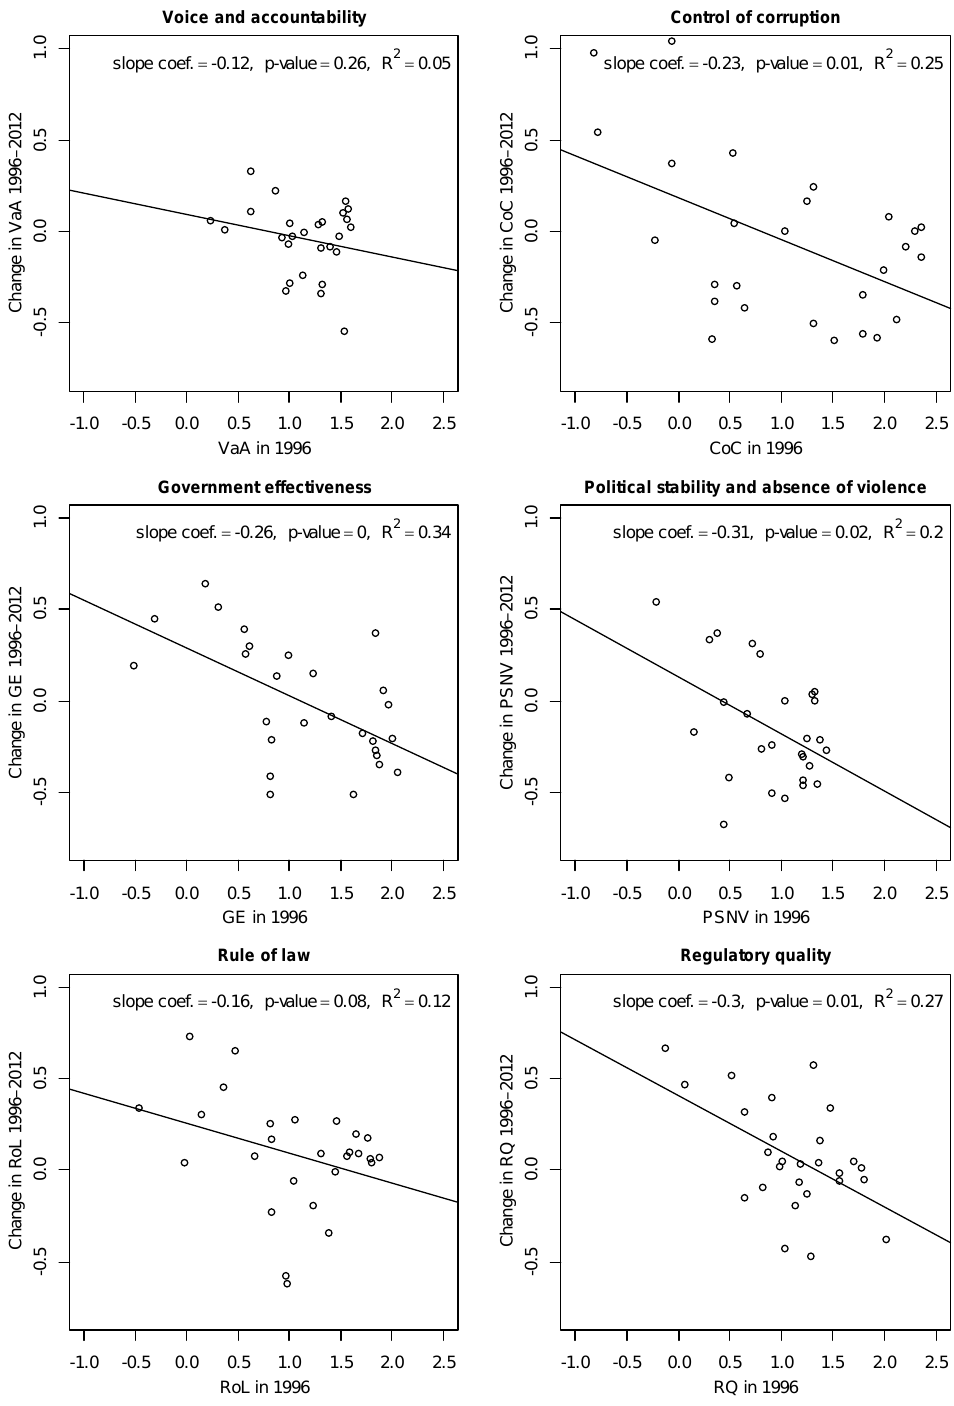
Data source: Kaufmann et al. 2013. Notes: The country group comprises the 27 EU Member States in 2012. VaA: voice and accountability; CoC: control of corruption; GE: government effectiveness; PSNV: political stability and absence of violence; RoL: rule of law; RQ: regulatory